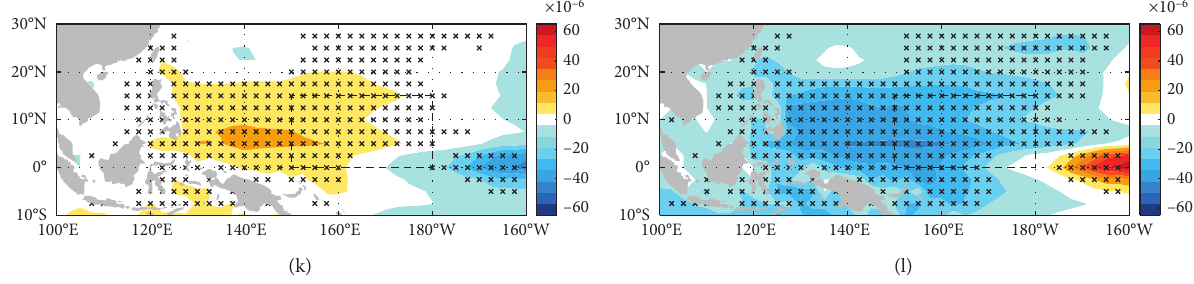
Figure 9: Composite anomalies of (a) the 1000hPa absolute vorticity (units: s − 1 ), (d) the mean temperature in the ocean mixed layer (units: ° C), (g) the net longwave radiation at the sea surface (units: W · m − 2 ), and (j) the depth of 26 ° C isotherm (units: m) in JASON season for the subsurface cold years; (b), (e), (h), and (k) as in (a), (d), (g), and (j), but for the subsurface warm years; (c), (f), (i), and (l) for the difference of composite anomalies between subsurface cold and warm years (cold-warm). Dashed rectangle indicates the main TC genesis area of southeastern quadrant mentioned in Section 4.2. The cross signs indicate that the values are statistically significant at the 95% confidence level.